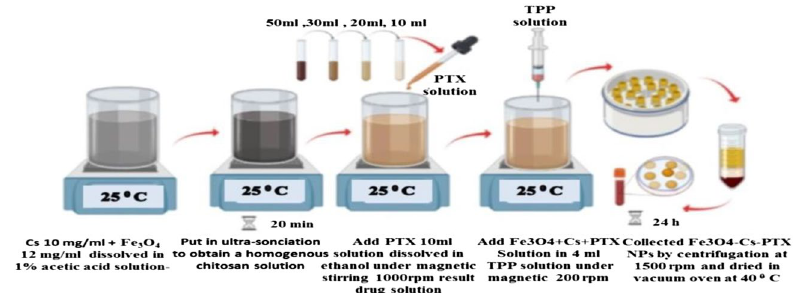
Figure 2. Schematic of the preparation and synthesis of SPION@Cs-PTX NPs.